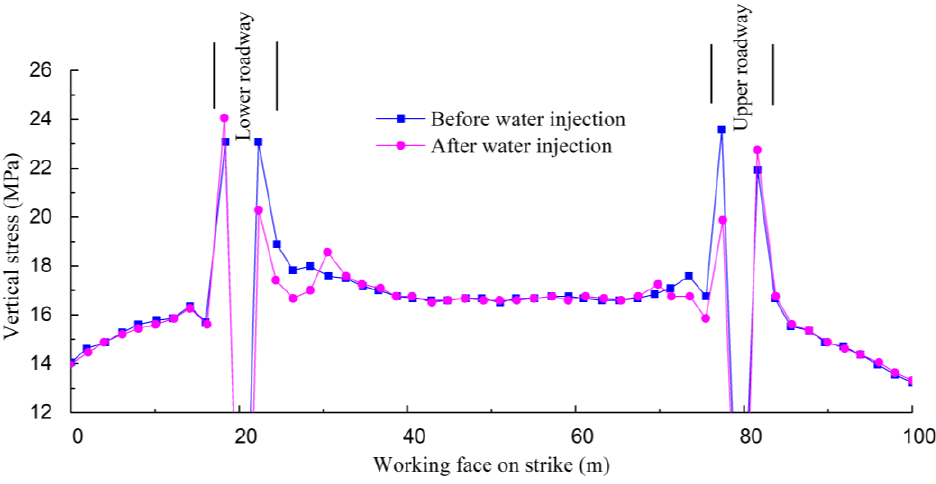
Figure 17. Vertical stress before and after water injection.